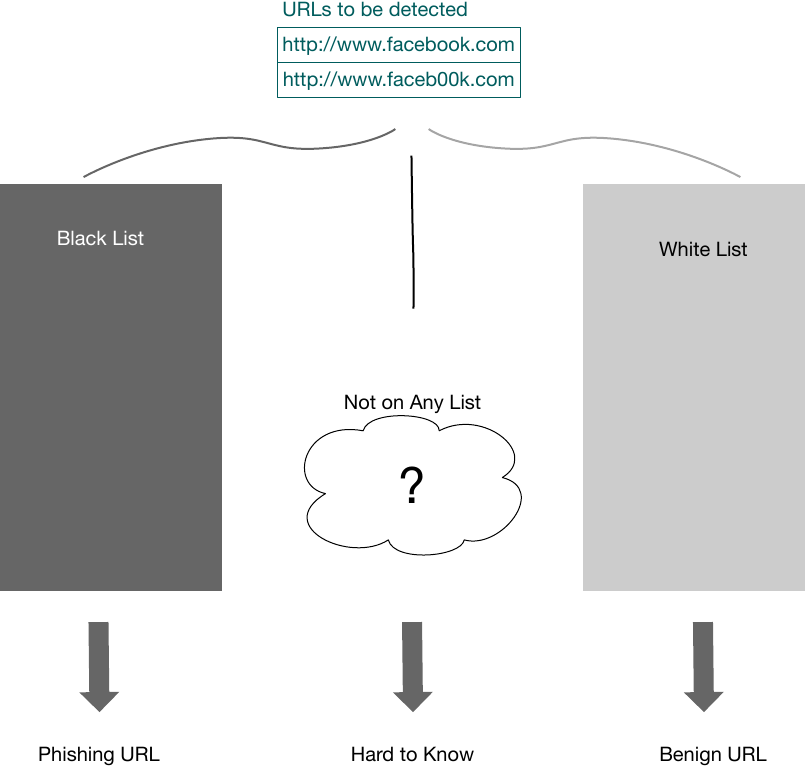
Figure 4. The mechanism of list-based phishing URL detection